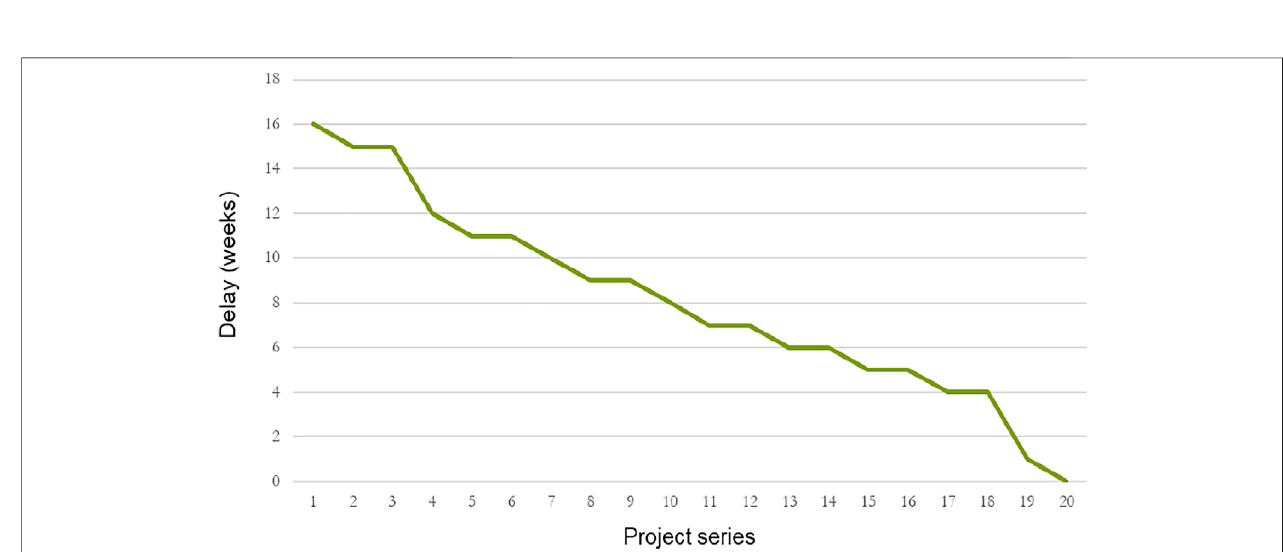
FIGURE 6 | Simulation results of construction